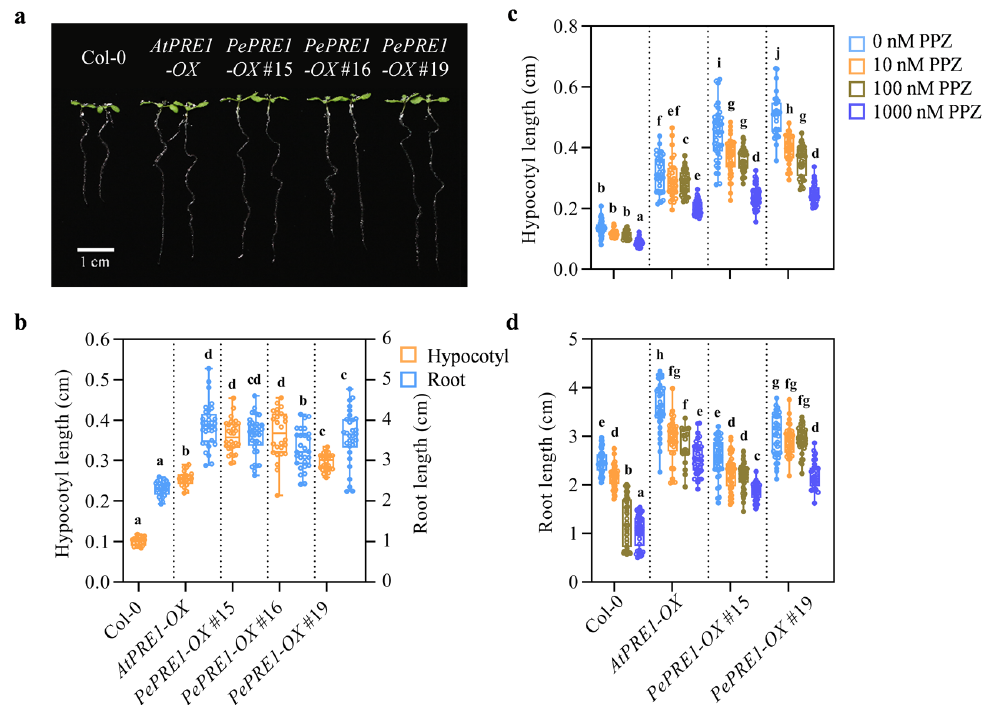
Figure 6. PePRE1-OX transgenic Arabidopsis exhibited longer hypocotyls and roots that were hypersensitive to PPZ treatment. ( a ) Representative seedlings of Col-0, AtPRE1-OX , and PePRE1-OX . The seeds were sown on half MS medium and grown for 7 days vertically. Scale bar presents 1 cm. ( b ) The hypocotyl and root lengths of the control and PePRE1-OX plants. Hypocotyl length ( c ) and root length ( d ) of di ff erent lines of PePRE1-OX compared with Col-0 with a gradient concentration (0 nM, 10 nM, 100 nM, and 1000 nM) of PPZ treatment. Values are the means calculated from at least 20 seedlings. Error bars represent mix/max values. Di ff erent le tt ers above the data column indicate signi fi cant di ff erences ( p < 0.05; Duncan’s test).